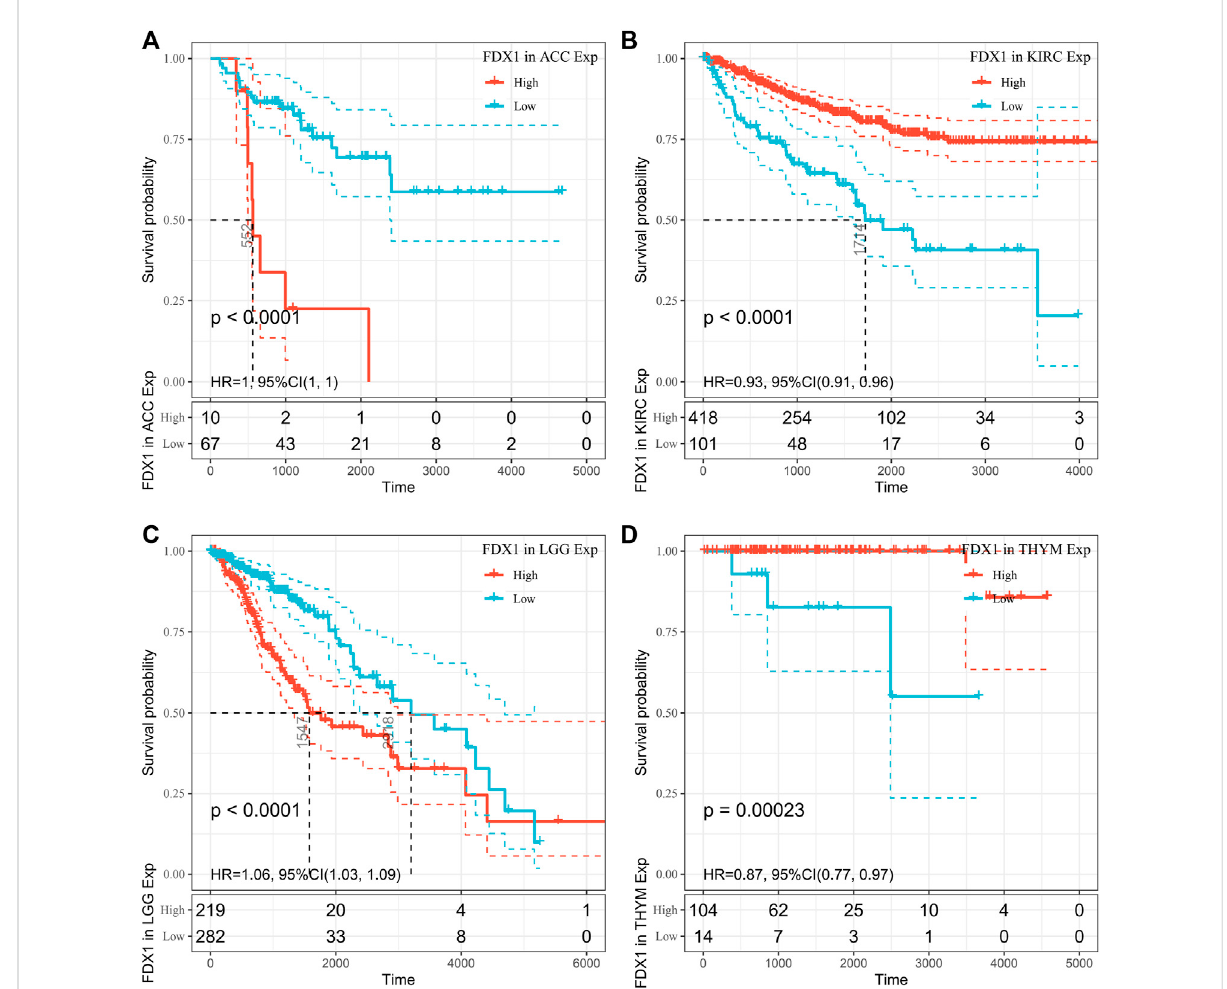
FIGURE 5 Disease-speci fi c survival (DSS) difference between high and low FDX1 mRNA expression groups in signi fi cantly prognostically relevant tumors fromtheCancerGenomeAtlasdatabase(bymedianexpressiondichotomy). (A) DSSdifferencesbetweenadrenalcorticalcarcinomagroups. (B) DSS differences between KIRC groups. (C) DSS differences between groups in LGG. (D) DSS differences between thymoma groups. p < 0.05 was considered a signi fi cant, 95% CI dashed